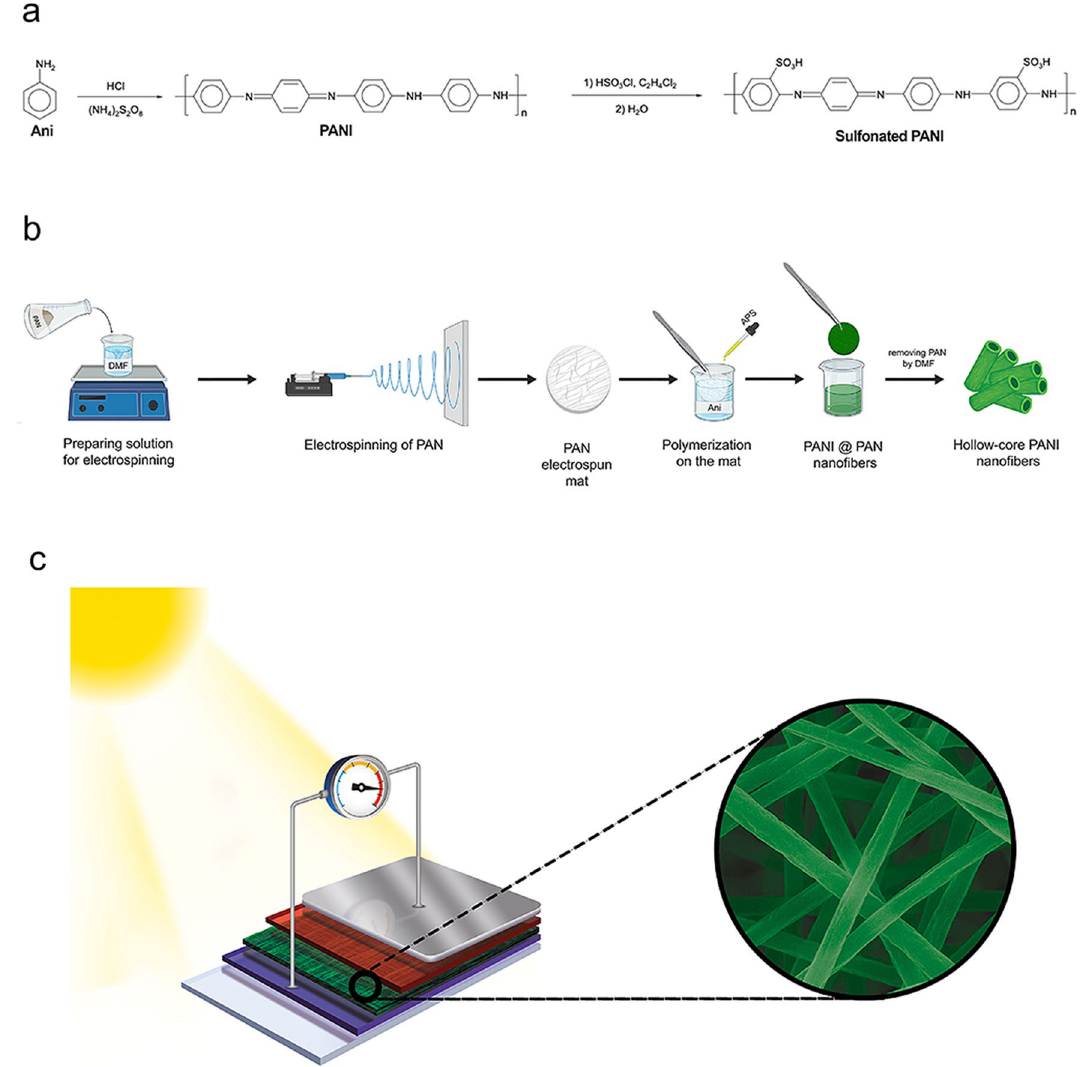
Figure 1. Development of the electrospun nanofiber-based organic solar cell. ( a ) Schematics of the PANI and sulfonated PANI syntheses. ( b ) Graphical representation of the preparation procedures of hollow core PANI nanofibers, combining electrospinning and a facile sacrificial template method. ( c ) Sketch representing the architecture of the organic solar cell. The inset shows the presence of hollow core PANI nanofibers in the structure of the